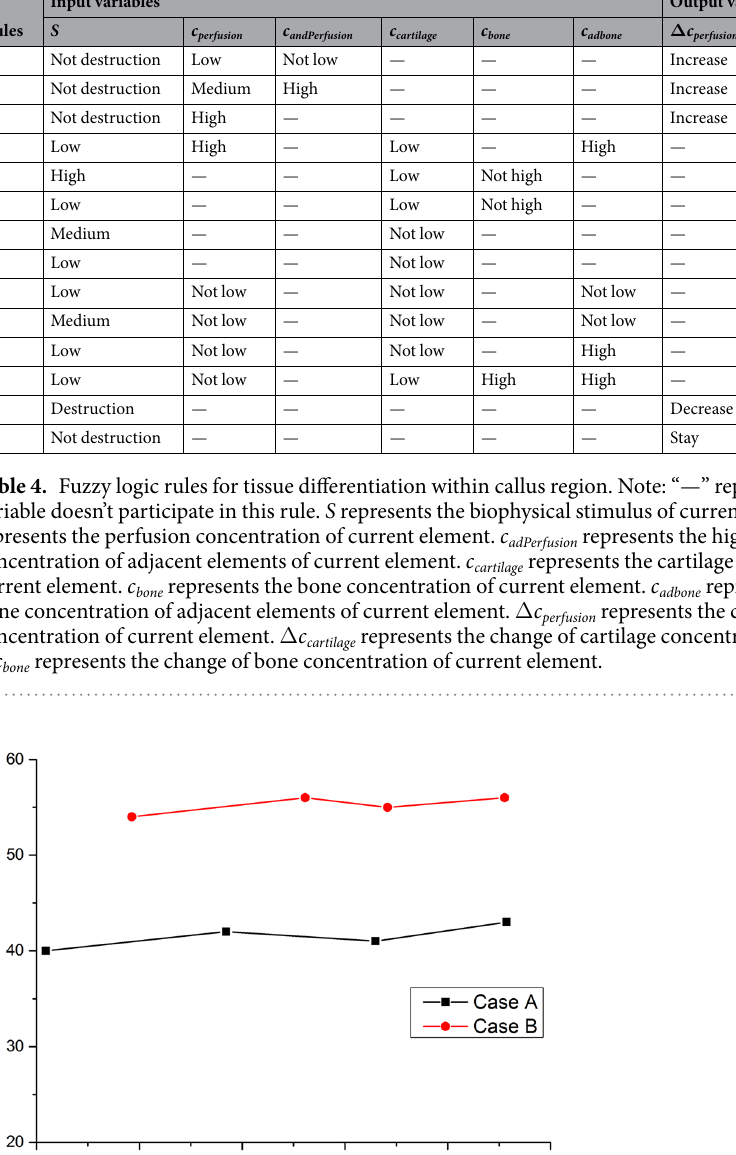
where v element represents element’s Possion’s ratio; v con represents Possion’s ratio of connective tissue, c elam,conn rep- resents the concentration of connective tissue in an element; v cart represents Possion’s ratio of cartilage, c elam,cart represents the concentration of cartilage in an element; v women represents Possion’s ratio of woven bone, c elam,woven represents the concentration of woven bone in an element. = + + perm perm where perm element represents element permeability; perm corn represents permeability of connective tissue, c elem,conn represents the concentration of connective tissue in an element; perm cart represents permeability of cartilage, c elem,cart represents the concentration of cartilage in an element; perm woven represents permeability of woven bone, c elem,woven represents the concentration of woven bone in an element.